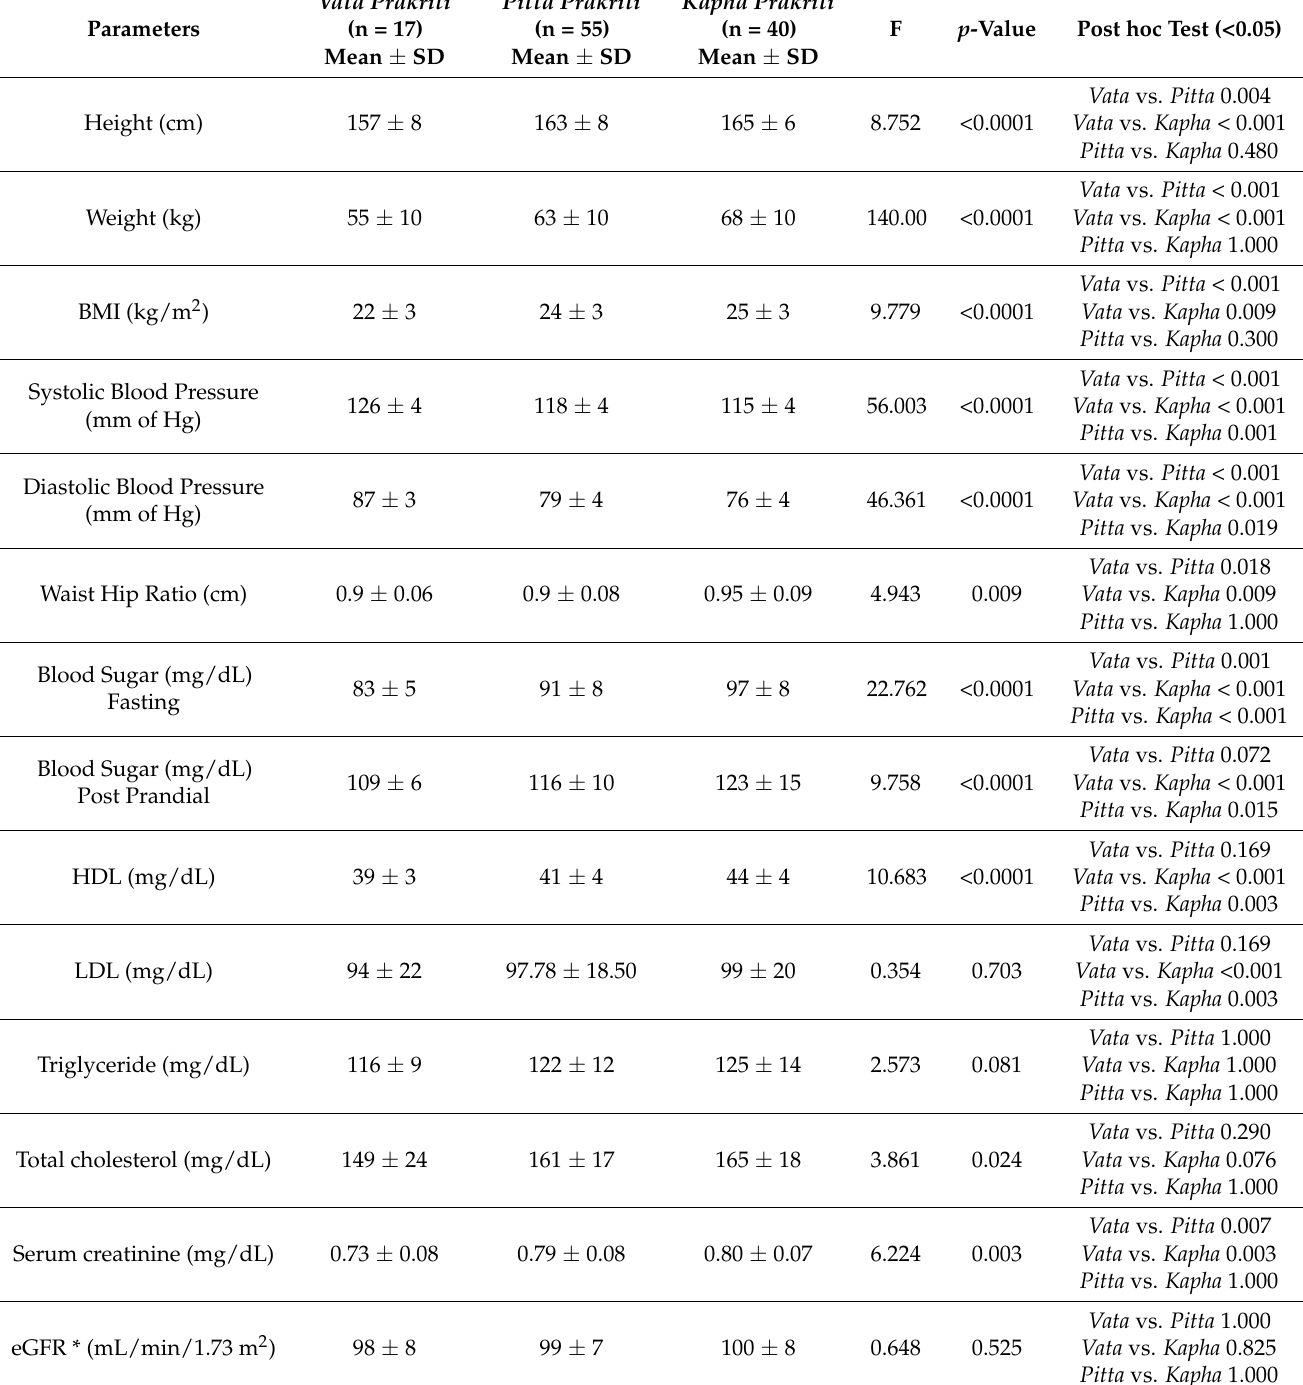
Table 3. Showing anthropometric and biochemical parameters of the group without diabetes subjects as per Prakriti